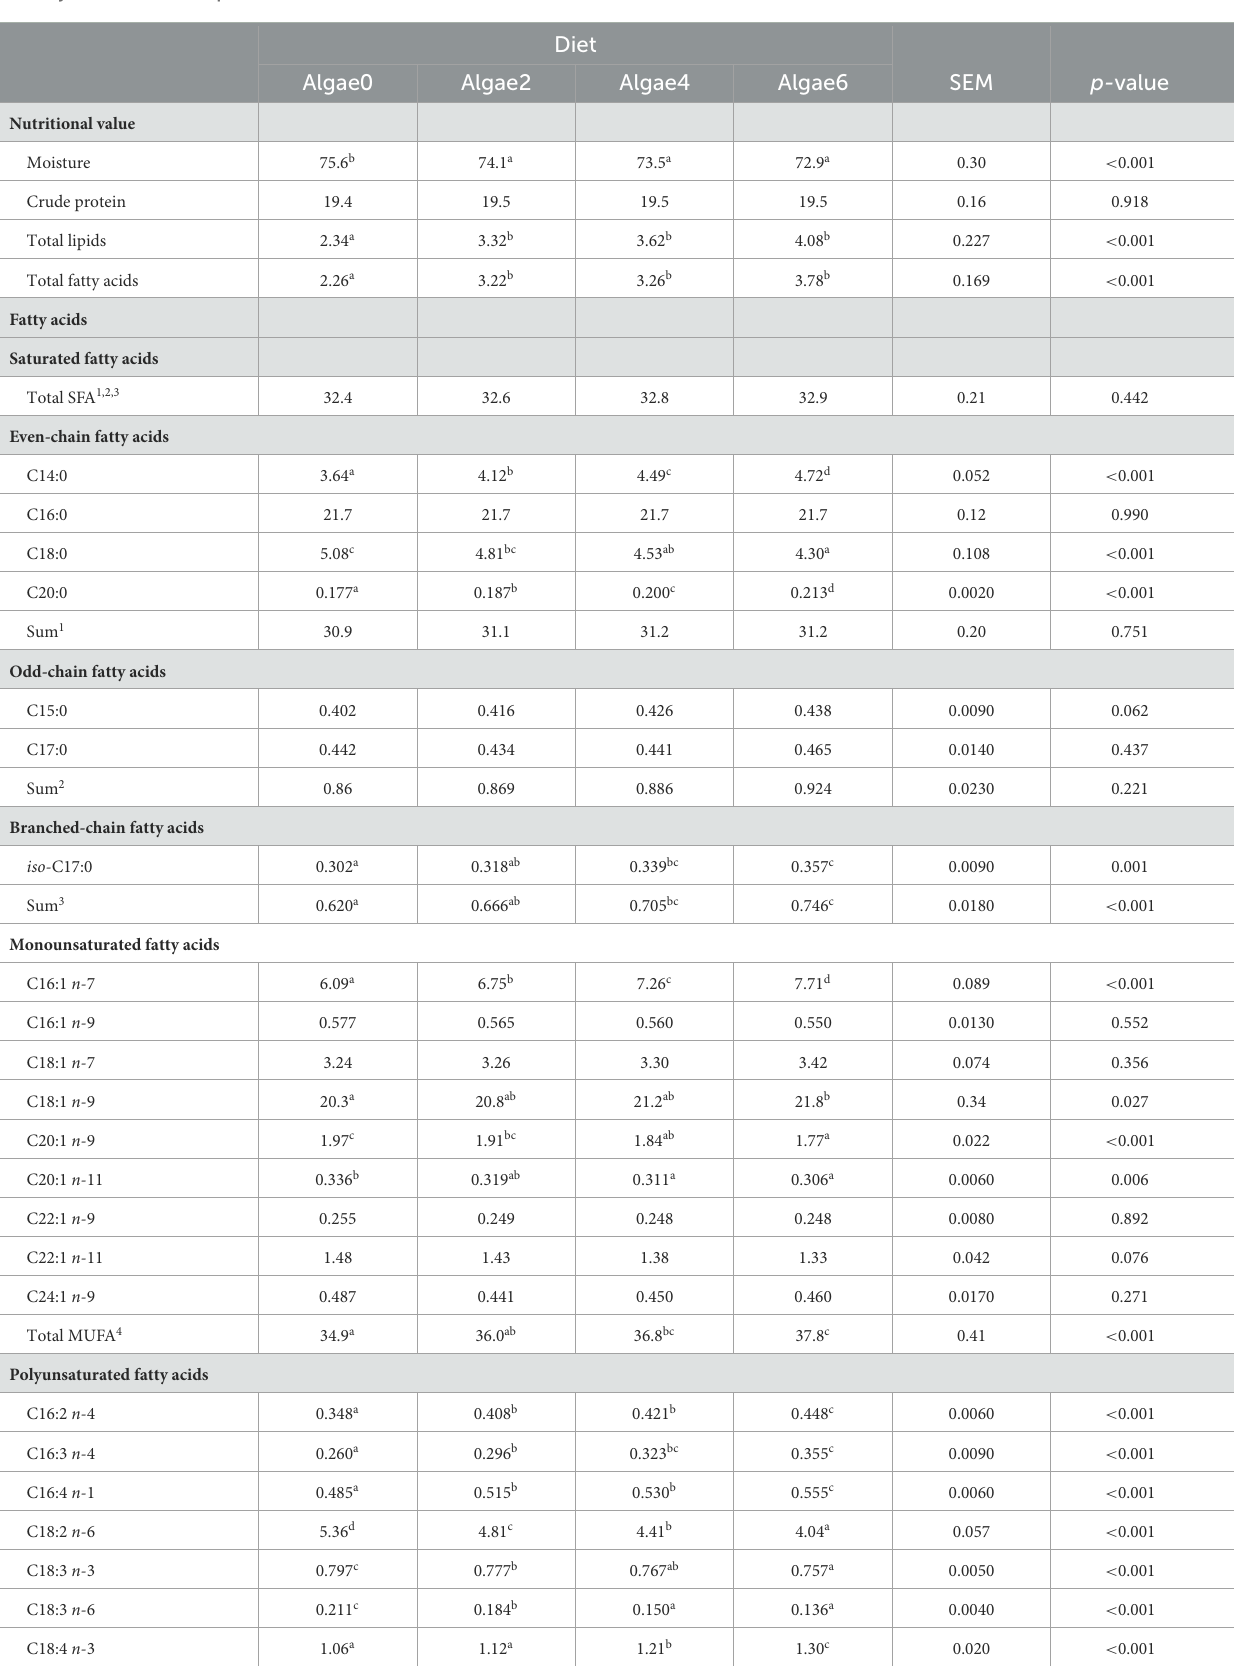
TABLE 7 Muscle nutritional value (g 100 g − 1 wet weight, ww), fatty acids profile (g 100 g − 1 total fatty acids), and lipid quality indices of European seabass juveniles fed the experimental diets. Diet Algae0 Algae2 Algae4 Algae6 SEM p-